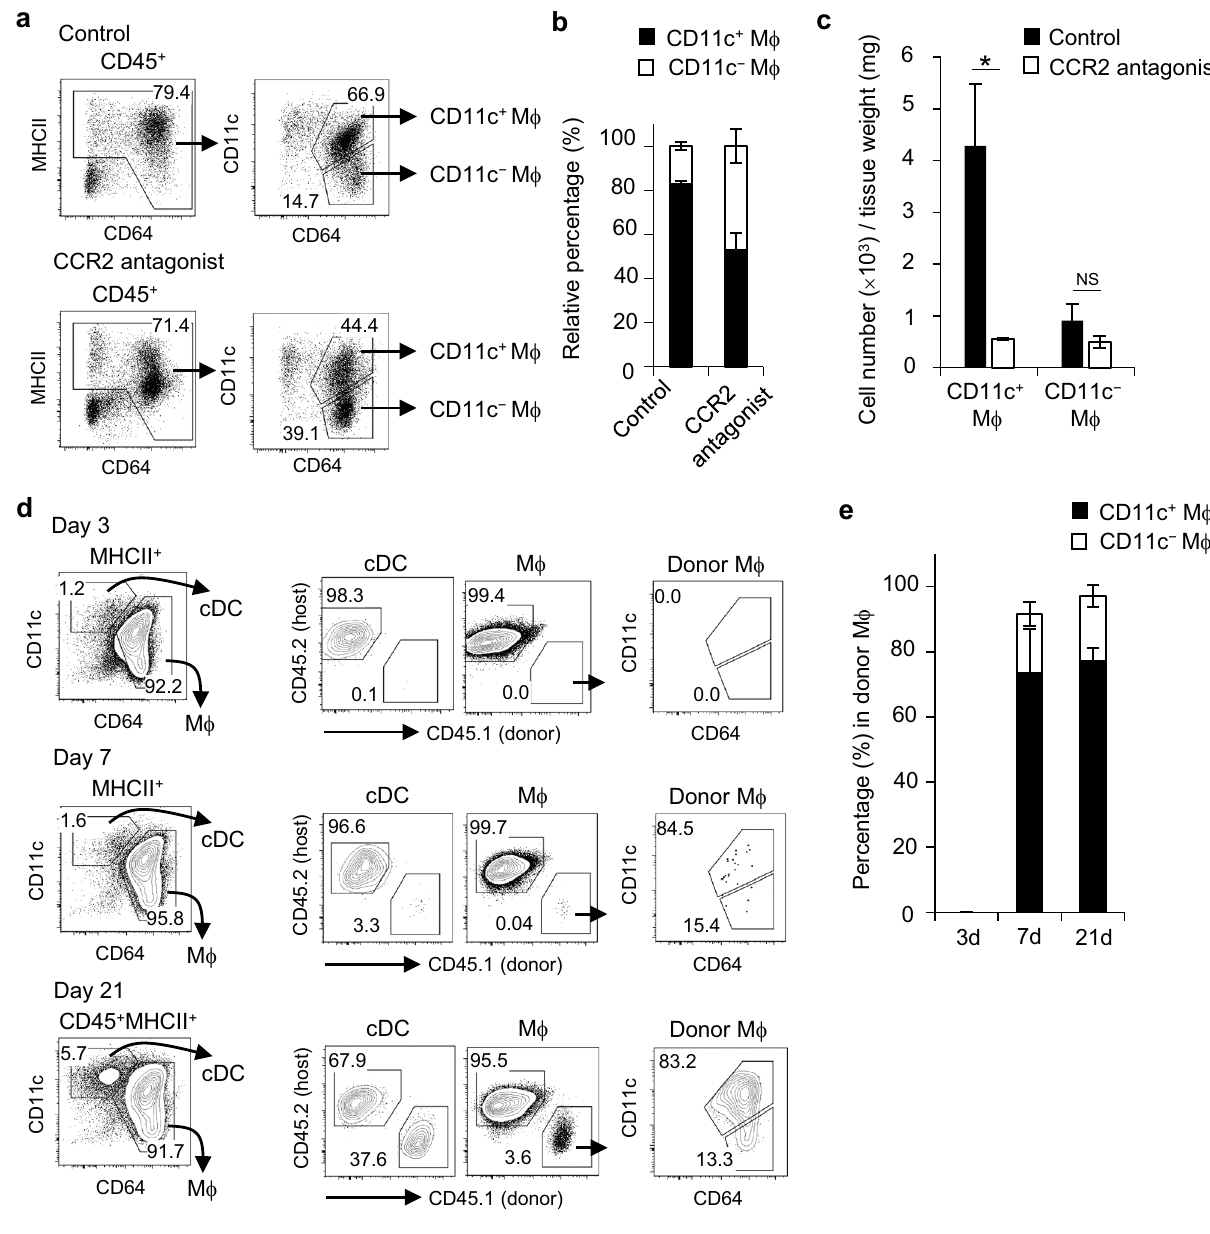
Figure 4. HSC dependency of macrophage subsets in steady-state SMGs. ( a – c ) Macrophage subsets in steady-state SMGs from control or CCR2 antagonist-treated mice. Newborn mice were administered the CCR2 antagonist from postnatal day 3 for 4 weeks, and SMG tissues were then harvested. Representative FACS plots ( a ). Data are representative of three independent experiments. The proportion ( b ) and absolute numbers ( c ) of CD11c + and CD11c − macrophages in steady-state SMGs from control or CCR2 antagonist-treated mice. ( d , e ) Sublethally irradiated female CD45.2 + mice (7 weeks old) mice were adoptively transferred with CD45.1 + BM cells. SMG tissues were harvested at the indicated time points and the percentage of donor-derived (CD45.1 + ) cDCs and macrophage subsets were analyzed by flow cytometry. Representative FACS plots ( d ) and the percentages of the CD11c + and CD11c − subsets in donor macrophages ( e ) are shown. Bars represent the mean ± SD ( n = 3). * P < 0.05 by the Student’s t test with Welch’s correction. Results are representative of three independent experiments. Mϕ macrophage, NS not